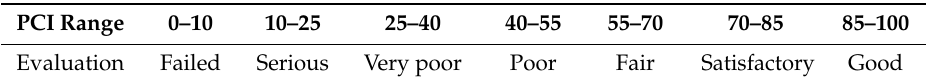
Table 3. The rating scale of